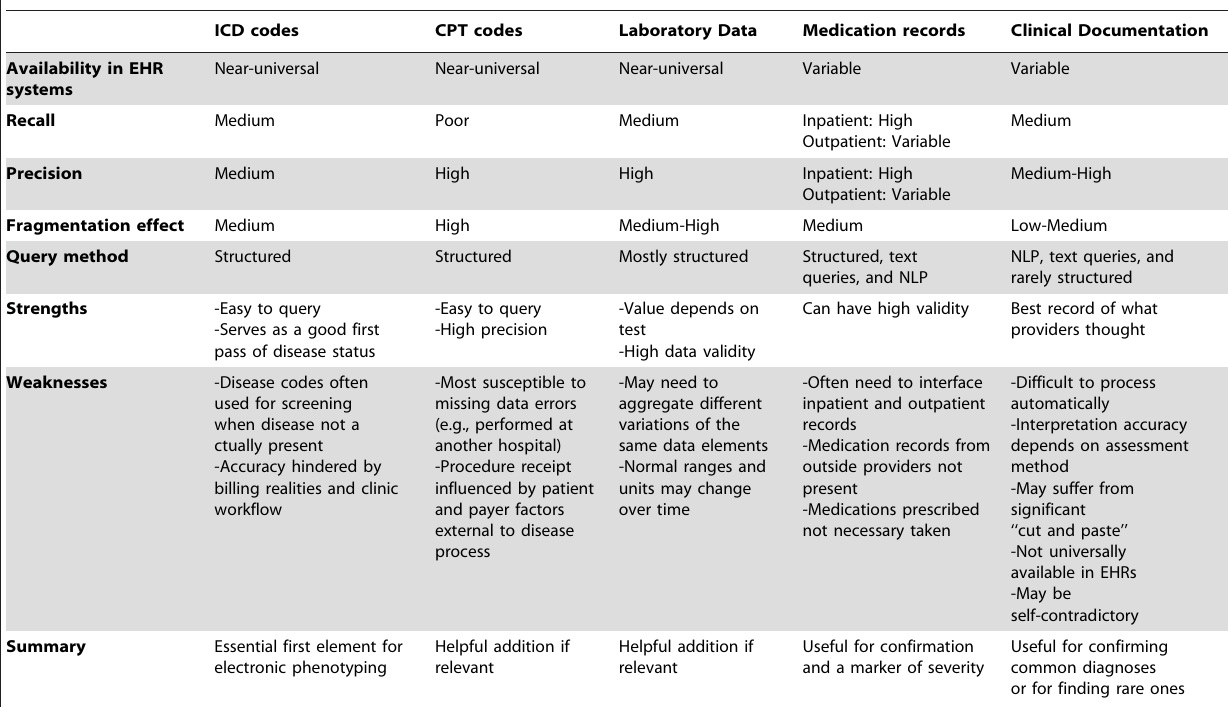
Table 1. Strengths and weakness of data classes within EHRs.